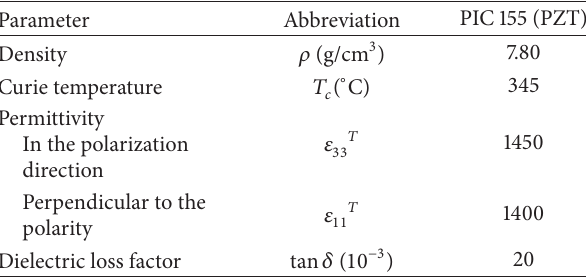
Figure 1: PZT patch sensor (PIC155). Table 1: Physical and dielectric properties PIC 155.